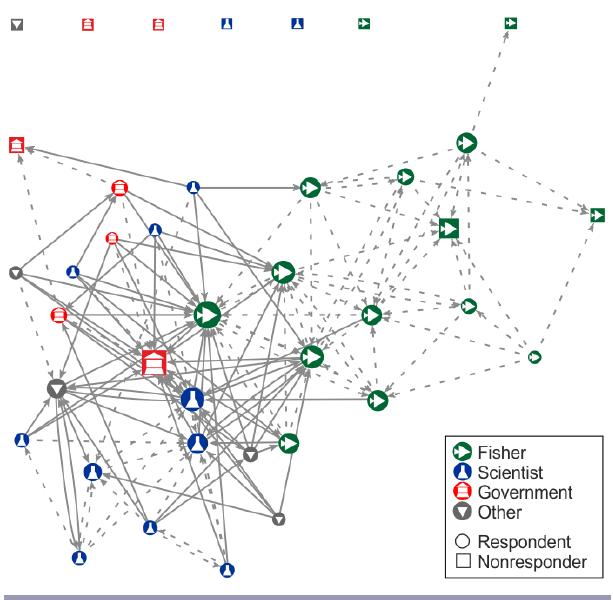
Fig. 1 . Sociogram of the discussion network with stakeholder type, Australian Northern Prawn Fishery (node size represents number of nominations, within-group ties are